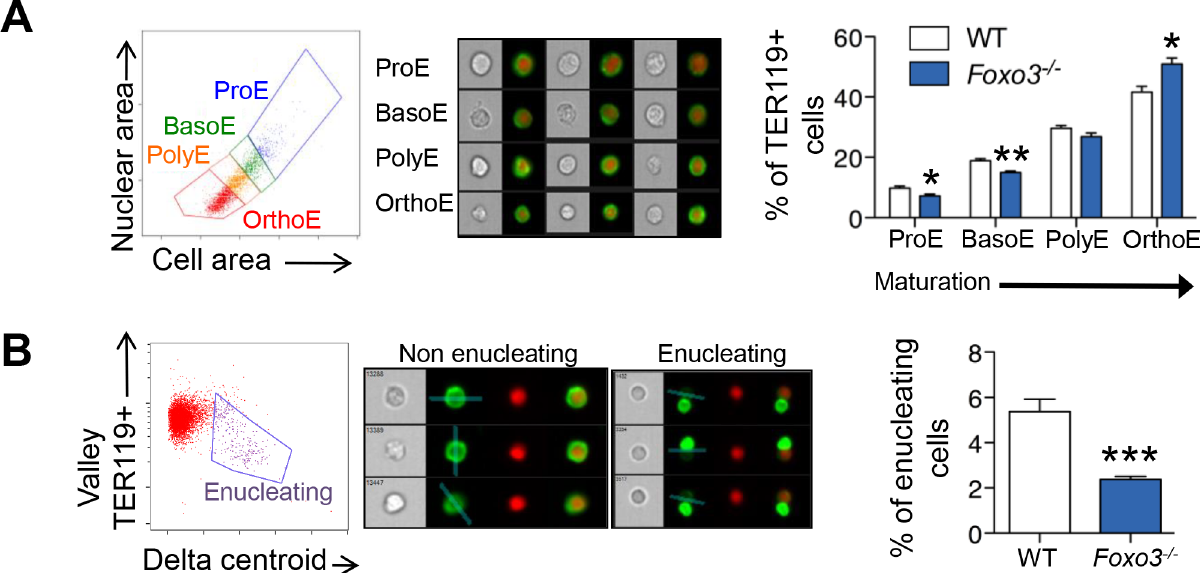
Fig 5. Defective Foxo3 -/- terminal erythroblast maturation. (A) Delineation of erythroblasts by imaging flow analysis based on decreasing cell and nuclear size (left). Images of typical cells (middle panel) in bright-field (gray) and composite image of TER119 (green) and DRAQ5 DNA stain (red). Results are mean ± SEM of n = 4. ( B ) Gating of enucleating cells from the orthochromatic erythroblasts (in A ) based on difference between the center of the nuclear stain and TER119 stain (Delta centroid on X) and a decreasing TER119 signal in the valley mask (highlighted in blue on TER119 image) which goes through the lowest signal point and thus marks the boundary between the reticulocyte and pyrenocyte. Cells with no signal in this mask are eliminated as close doublets. Results are mean ± SEM of n = 4. * P < 0.05 ** P < 0.01 *** P < 0.001, Student ’ s t